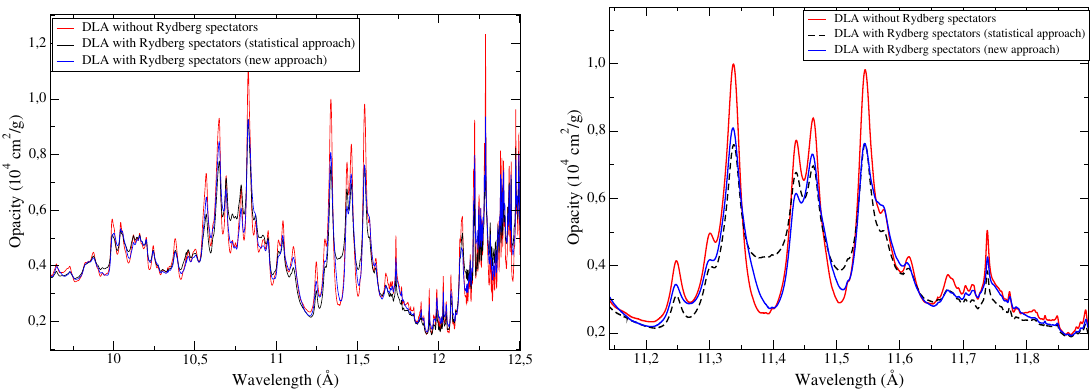
Figure 15. Modelling of satellites [Be] 2p 5 (5s · · · 8d) 1 → 2p 4 4d(5s · · · 8d) 1 with SCO-RCG code.